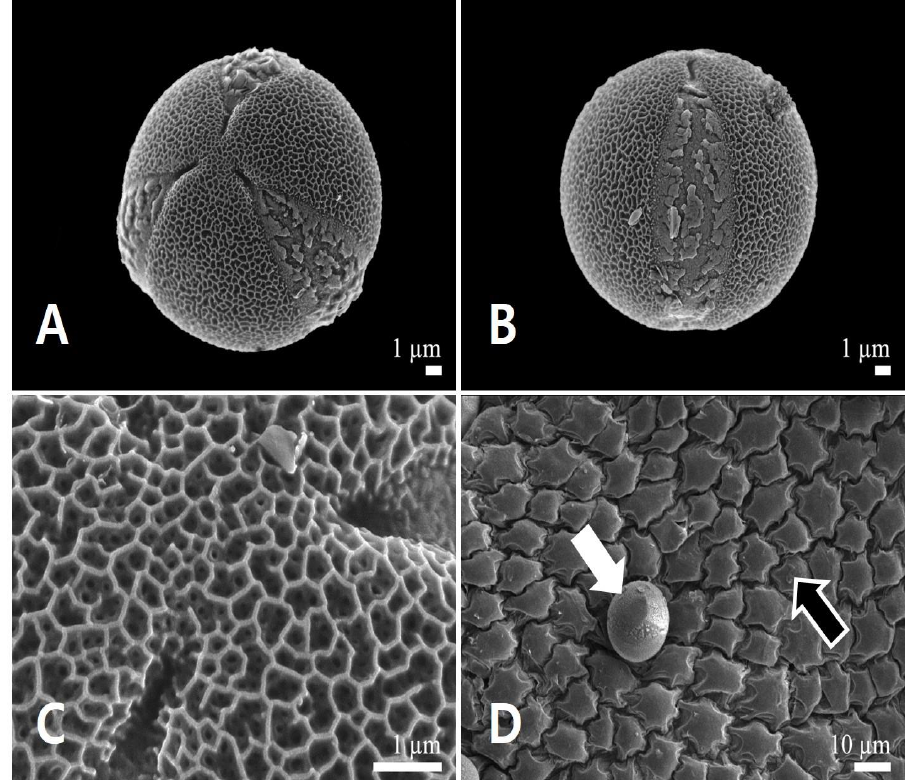
Figure 5. Scanning electron micrographs of pollen and the inner locule wall in Leonurus japonicus . ( A ) Polar view of a pollen grain. ( B ) Equatorial view of a pollen grain. ( C ) Exine surface ornamentation. ( D ) Inner locule wall. White arrow indicates pollen grain, and black arrow indicates the inner locule. Table 3. Distribution patterns of trichomes and stomata on the floral organs of the two Leonurus species ( • =